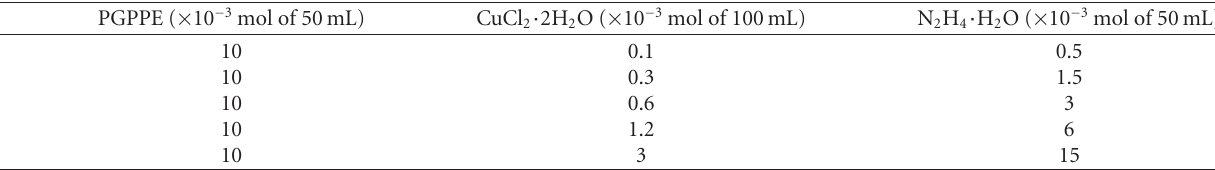
Table 2: Specifications of each solution with varying copper chloride concentrations.